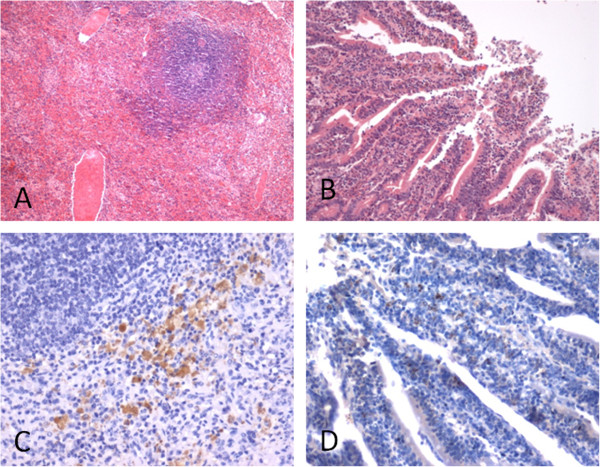
The pathology detection following inoculated with BVDV JL-1. Histopathology appearances of H&E-stain (A and B), A. spleen, showing the significantly wided periarterial lymphatic sheath and lymphocytes depletion in red pulp (100×); B. intestines: showing hemorrhage and shedding in the small intestine villi (100×). Immunohistochemistry (IHC) detection of BVDV antigen (C and D). C. spleen, virus antigens in mononuclear cells randomly scattered in splenic red pulp (200×); D. virus antigens in epithelium of intestines (200×).